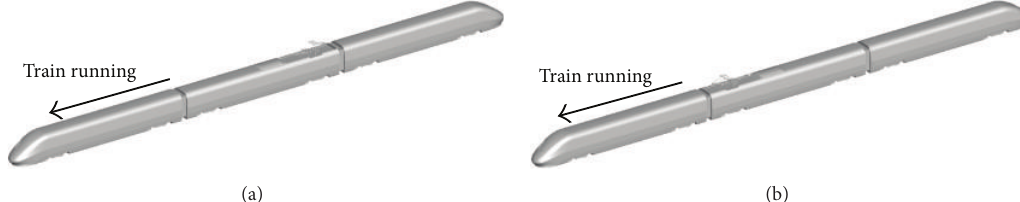
Figure 23: Different pantograph fairing installation positions: (a) rearward position and (b) forward position.